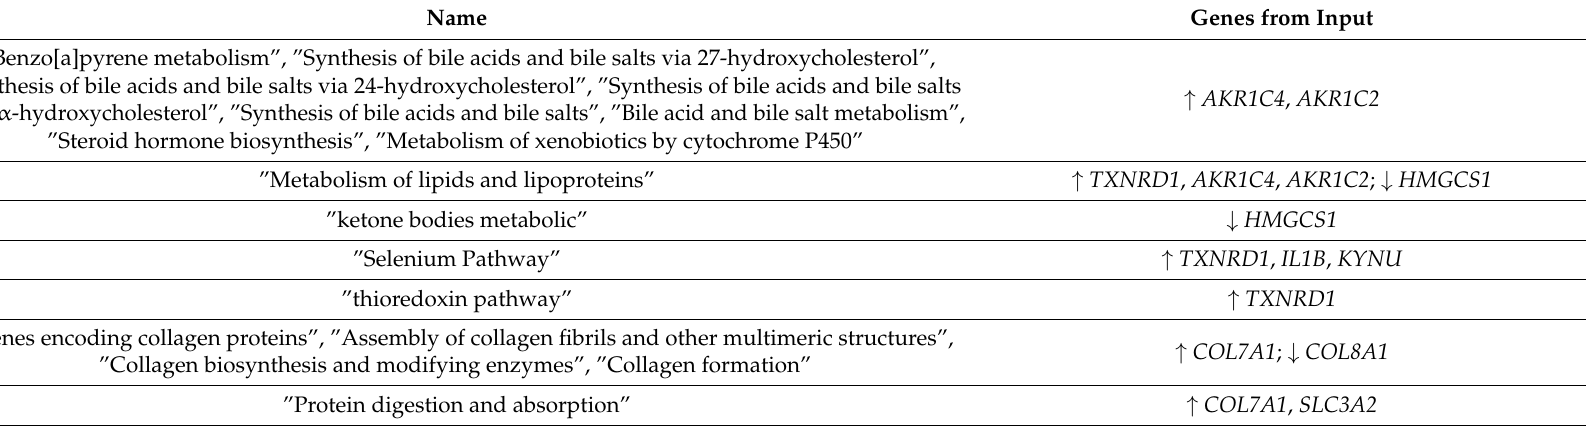
Table 3. Top ranked over-represented pathways shared by all DEP extract treatments following 24 h incubation. Significant upregulation resp. downregulation of genes: ↑↓